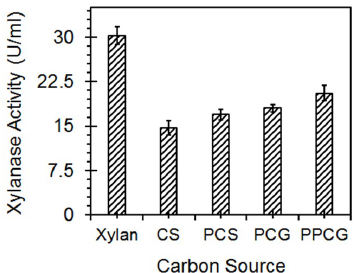
Figure 11. Enzyme production with untreated and mechanically treated corn stover and prairie cordgrass with comparison to xylan under optimized conditions. The values are mean of triplicate experiments and the error bars represent ± SD of the means with n = 3.